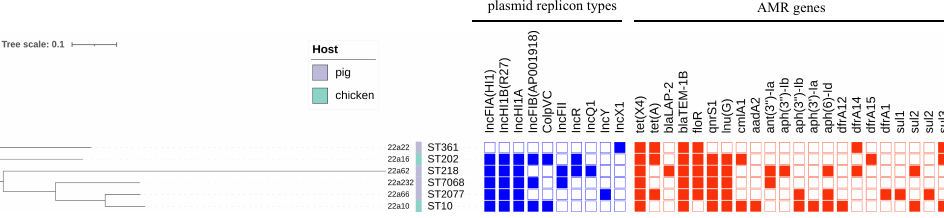
Figure 1. The phylogenetic tree and genomic features of six tet (X4) − positive E. coli isolates. The heatmap in different colors depicts the presence or absence of the plasmid replicon types (blue) and antimicrobial − resistance (AMR) genes (red). The whole genome sequence data of six E. coli strains have been submitted to NCBI under the BioProject accession number PRJNA898522. Table 1. The MIC of 6 tet (X4) − positive E. coli strains.